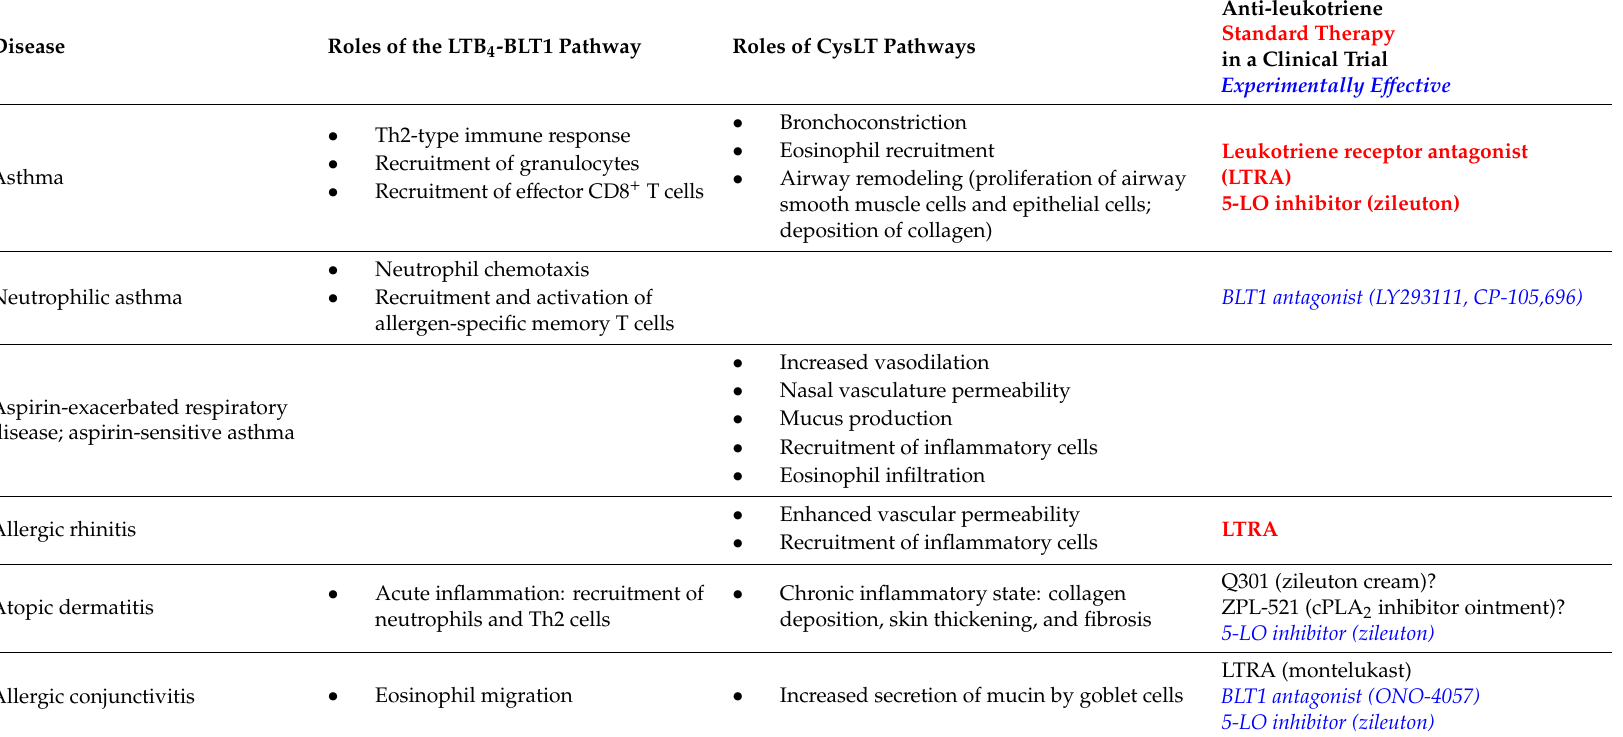
Table 1. Pathophysiological roles of leukotrienes and treatment strategies for allergic